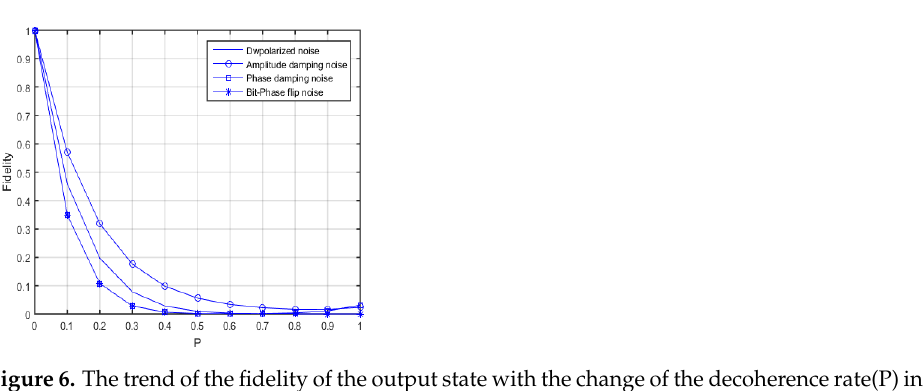
Figure 6. The trend of the fidelity of the output state with the change of the decoherence rate(P) in four types of noisy environments, where different types of lines represent different noise environments.